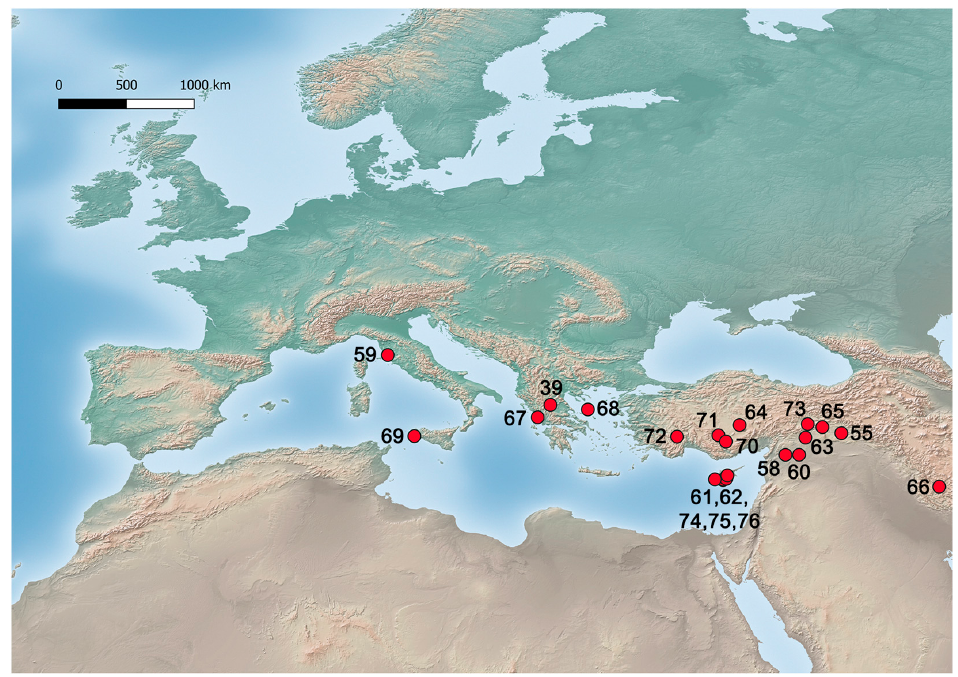
Figure 7. Lower Holocene sites where Celtis remains were reported (numbers in the figure correspond to ID numbers in Table 4) (map generated using QGIS version 3.4.13; Source: Natural Earth Data). Table 4. Lower Holocene sites where Celtis remains were reported (types of remains: wood charcoal (C), endocarp (E), pollen (P), phytoliths